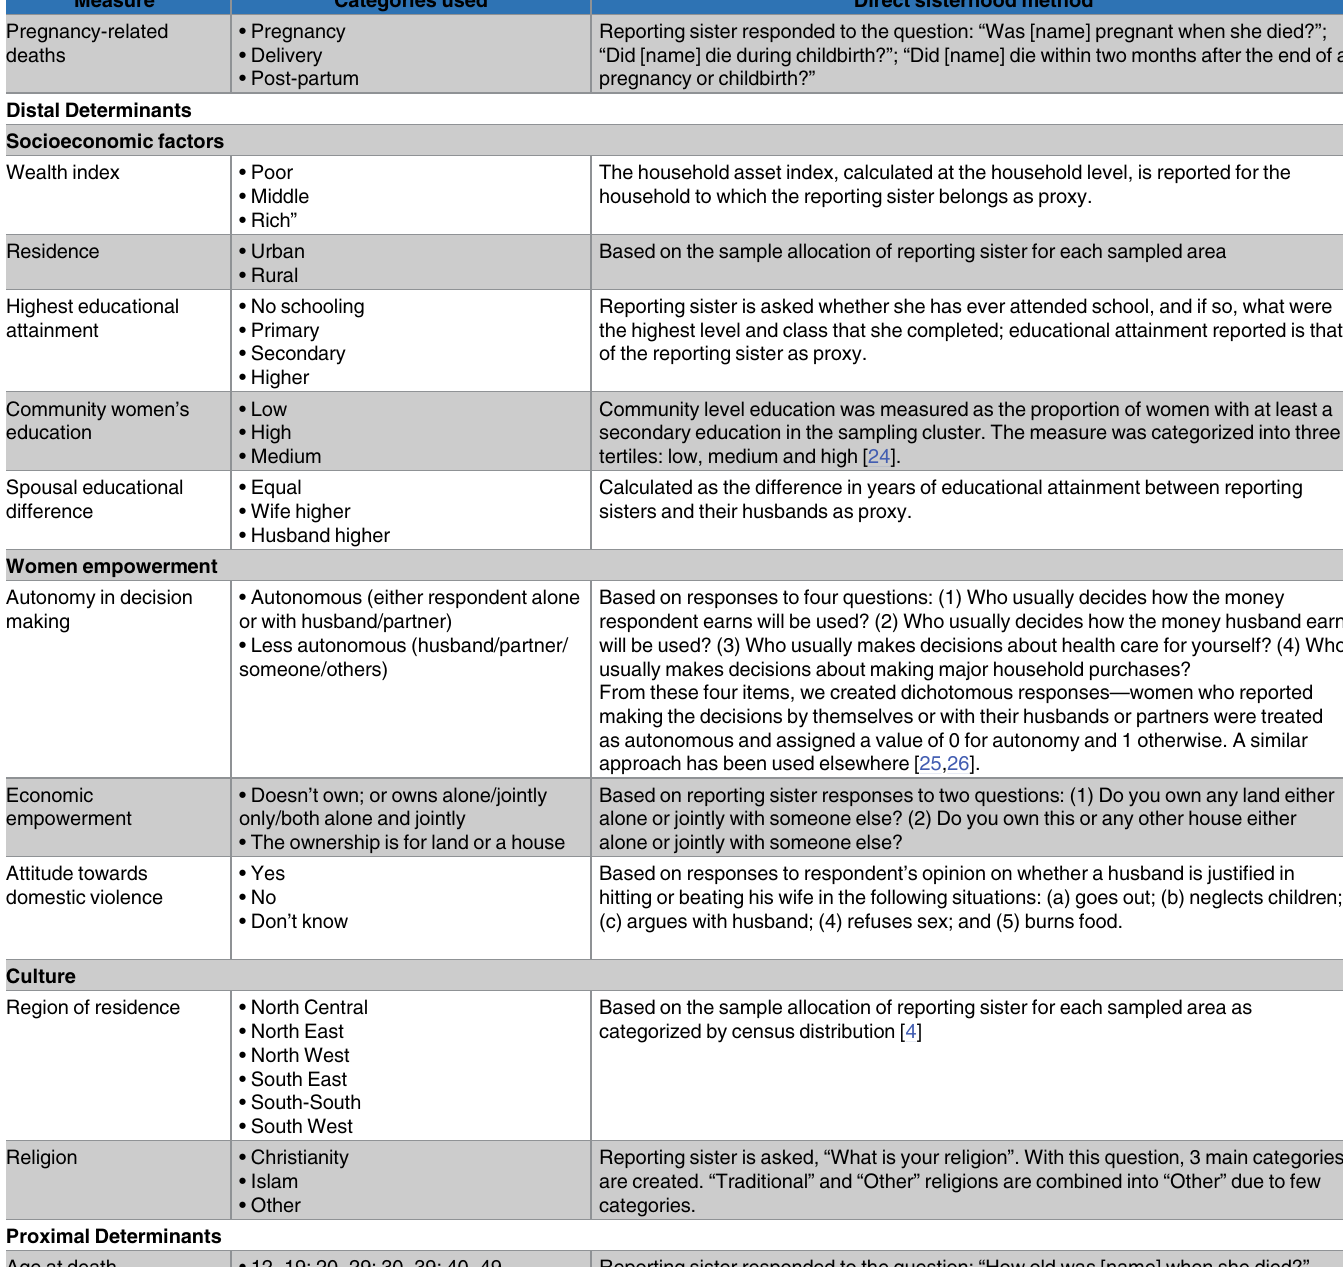
Table 1. Characteristics of pregnancy-related deaths identified using the direct sisterhood method, Nigeria Demographic and Health Survey 2013.